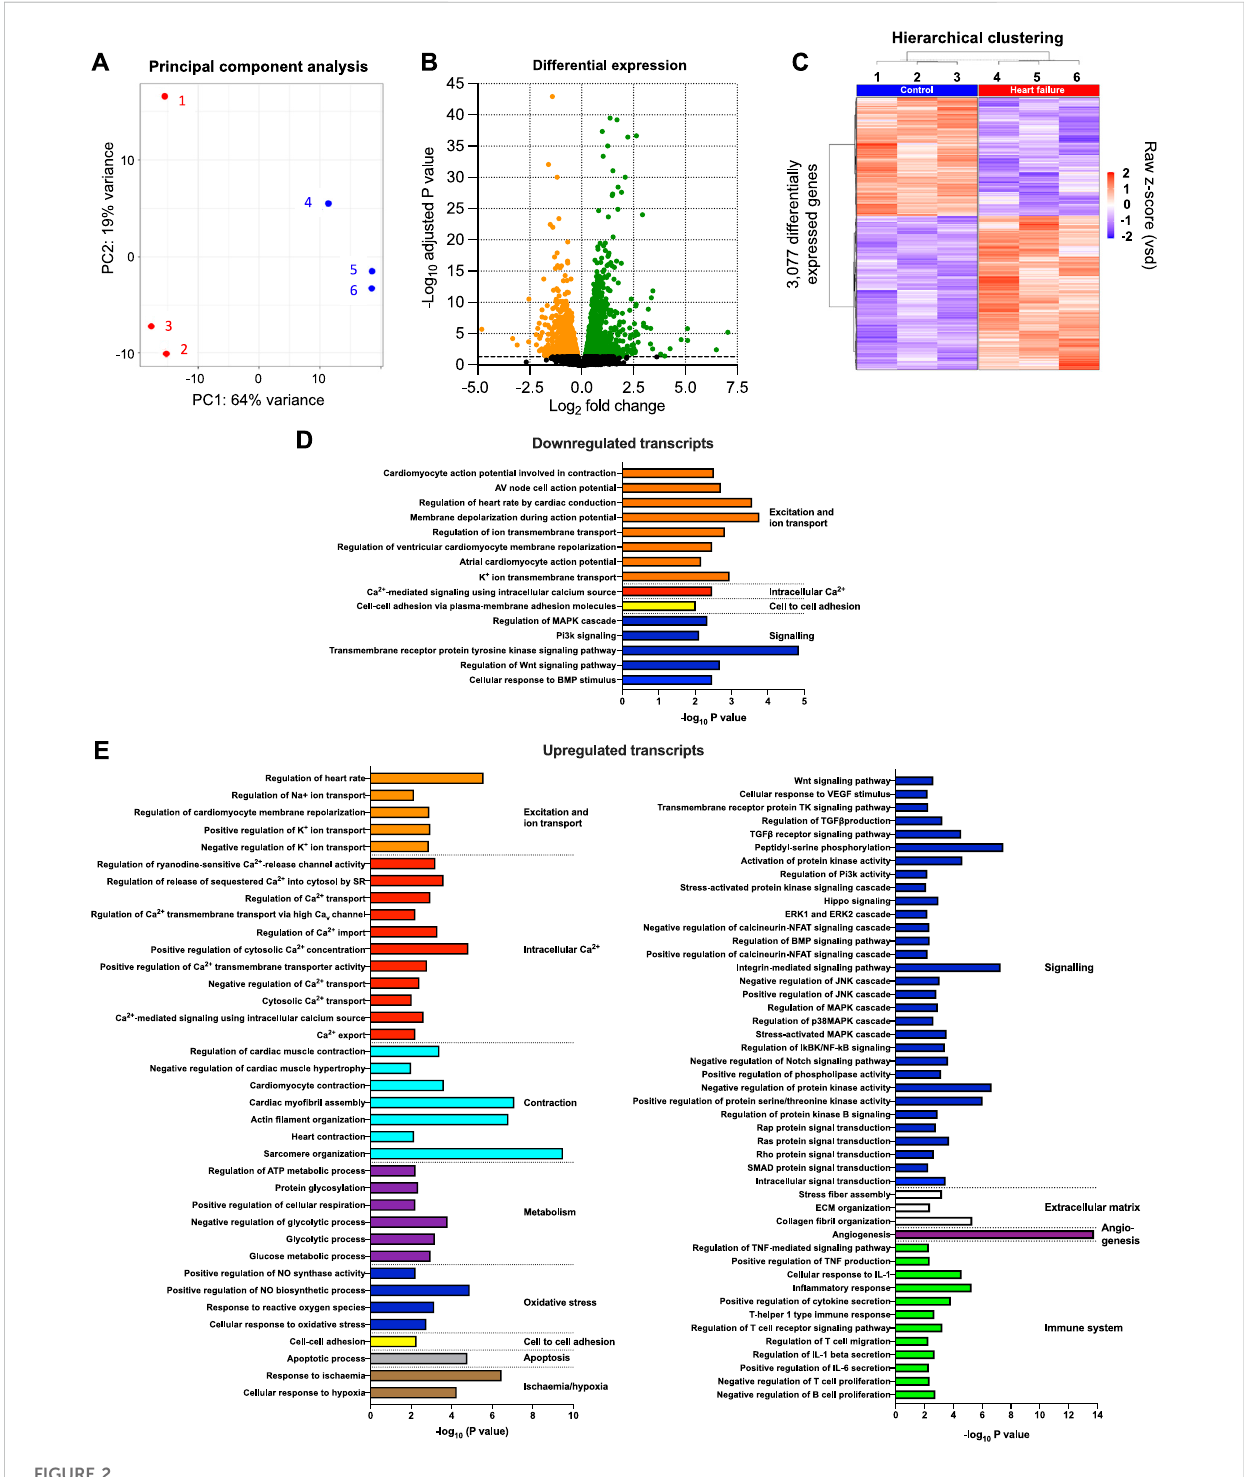
FIGURE 2 Transcriptomic remodelling of the AV node in HF. (A) , principal component analysis (PCA) of all six replicates based on the 500 most highly expressed transcripts. The x -axis shows the PCA 1 score, which represents the maximum variance direction in the data set. This is principal component 1 (PC1) and it accounts for 64% of the variance in the samples and can be attributed to the variance between the control and HF cohorts. The y -axis shows thePCA 2 score, which represents thesecond highestvariancedirectionin the data set. This is principal component 2 (PC2) and it accounts for 19% of the variance in the samples and can be attributed to the variance among all samples. The red symbols (1, 2 and 3) represent the three HF technical replicates and the blue symbols (4, 5 and 6) represent the three control technical replicates. Each technical replicate contained three pooled AV node biopsies. (B) , volcano plot showing -log 10 adjusted p -value plotted against log 2 fold change for each transcript measured. Dashed line corresponds to adjusted p = 0.05. The red and blue symbols show the 3,077 transcripts signi fi cantly upregulated (red symbols; 1,740 transcripts) or downregulated (blue symbols; 1,337 transcripts). (C) , hierarchical clustering of the 3,077 differentially expressed transcripts (adjusted p < 0.05) performed using Pearson ’ s correlation distance andward.D2agglomerationmethod.Data forthesixsamplesshown. Expression(rawz-score) goesfrom high(red)to low(blue).